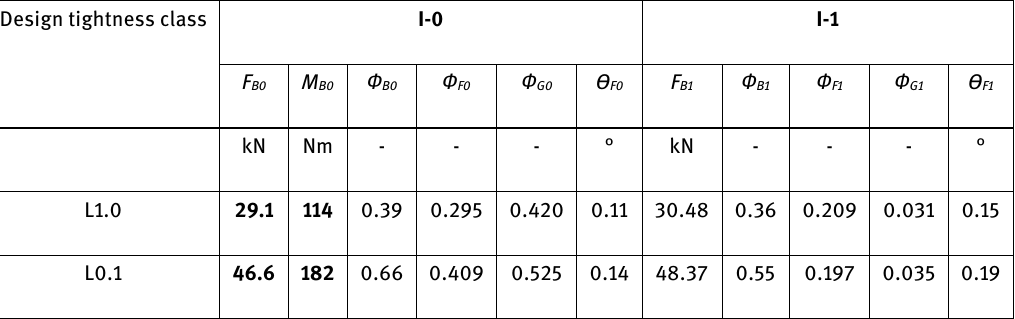
Table 3: The selected results of the flange-bolted PN40 DN 100 gasketed with material FG_2 Design tightness class